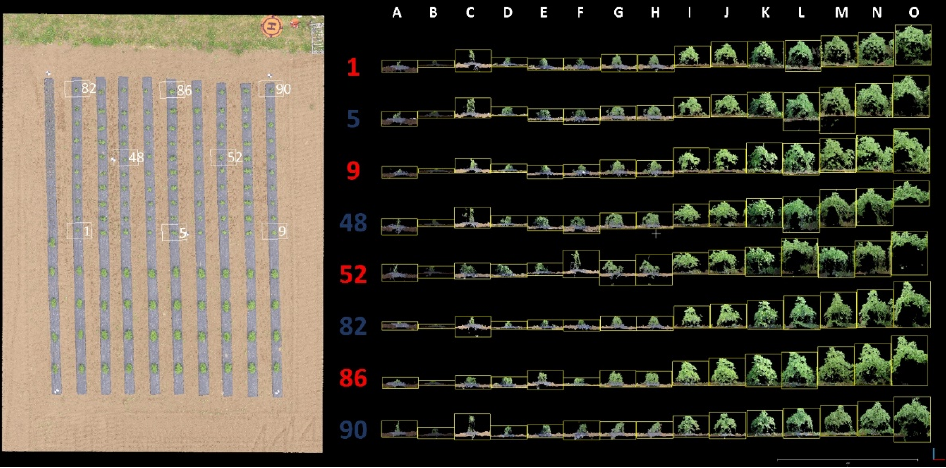
Figure A1. Examples of time series point cloud cropping. Each column is a flight during the growing season.